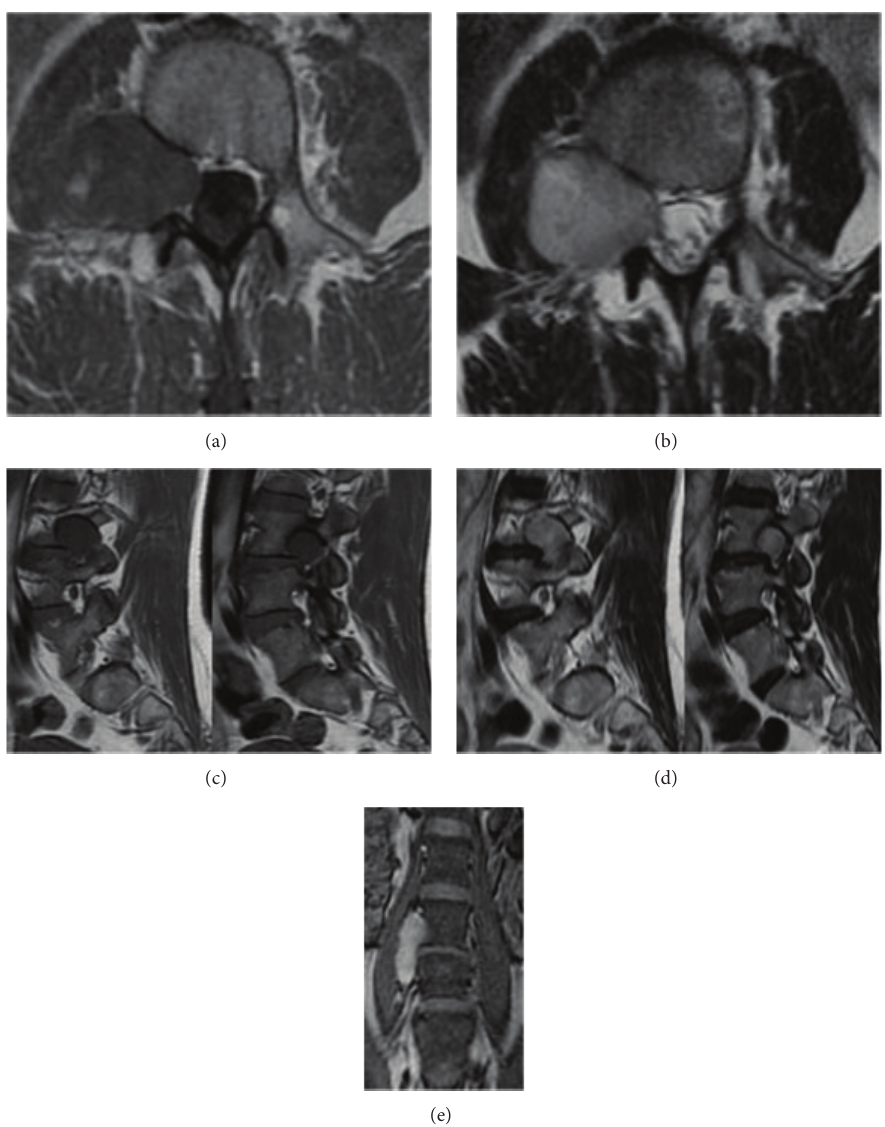
Figure 1: Preoperative MRI documents a right L3/L4 completely extradural dumbbell-shaped tumor with extraforaminal extension into the right psoas muscle: (a) T1-weighted; (b) axial T2-weighted with gadolinium enhancement; (c) sagittal T1-weighted showing extraforaminal and foraminal tumor components; (d) sagittal T2-weighted with gadolinium enhancement showing extraforaminal and foraminal tumor components; (e) coronal view with